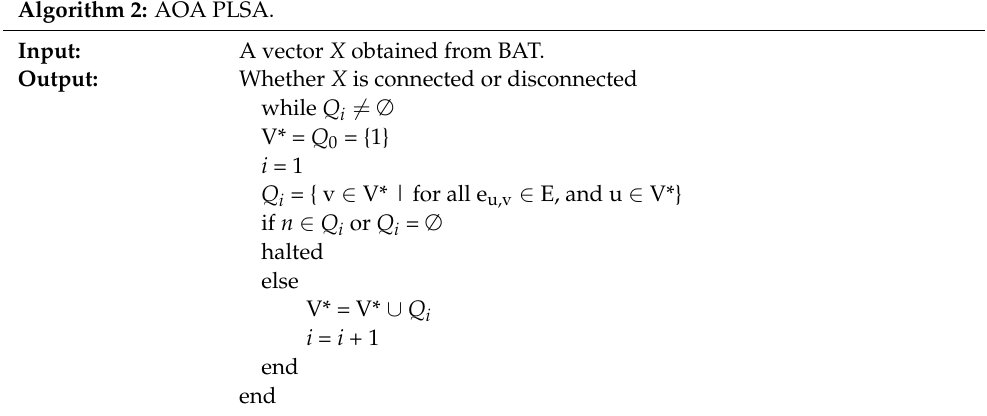
Algorithm 2: AOA PLSA.